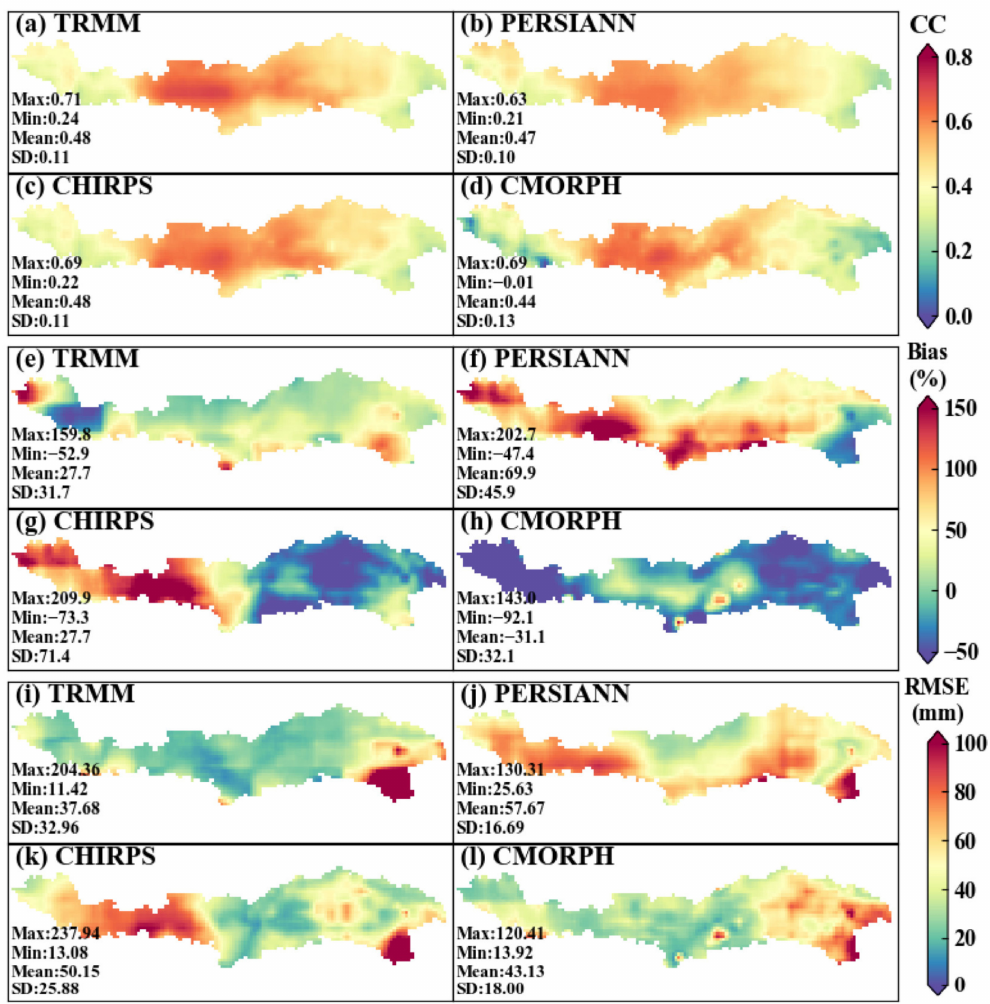
Figure 3. Spatial distribution of correlation metrics (CC, Bias, RMSE) of monthly precipitation during 2000–2008: ( a – d ) the spatial distribution of CC values; ( e – h ) the spatial distribution of B \ bias values; ( i – l ) the spatial distribution of RMSE